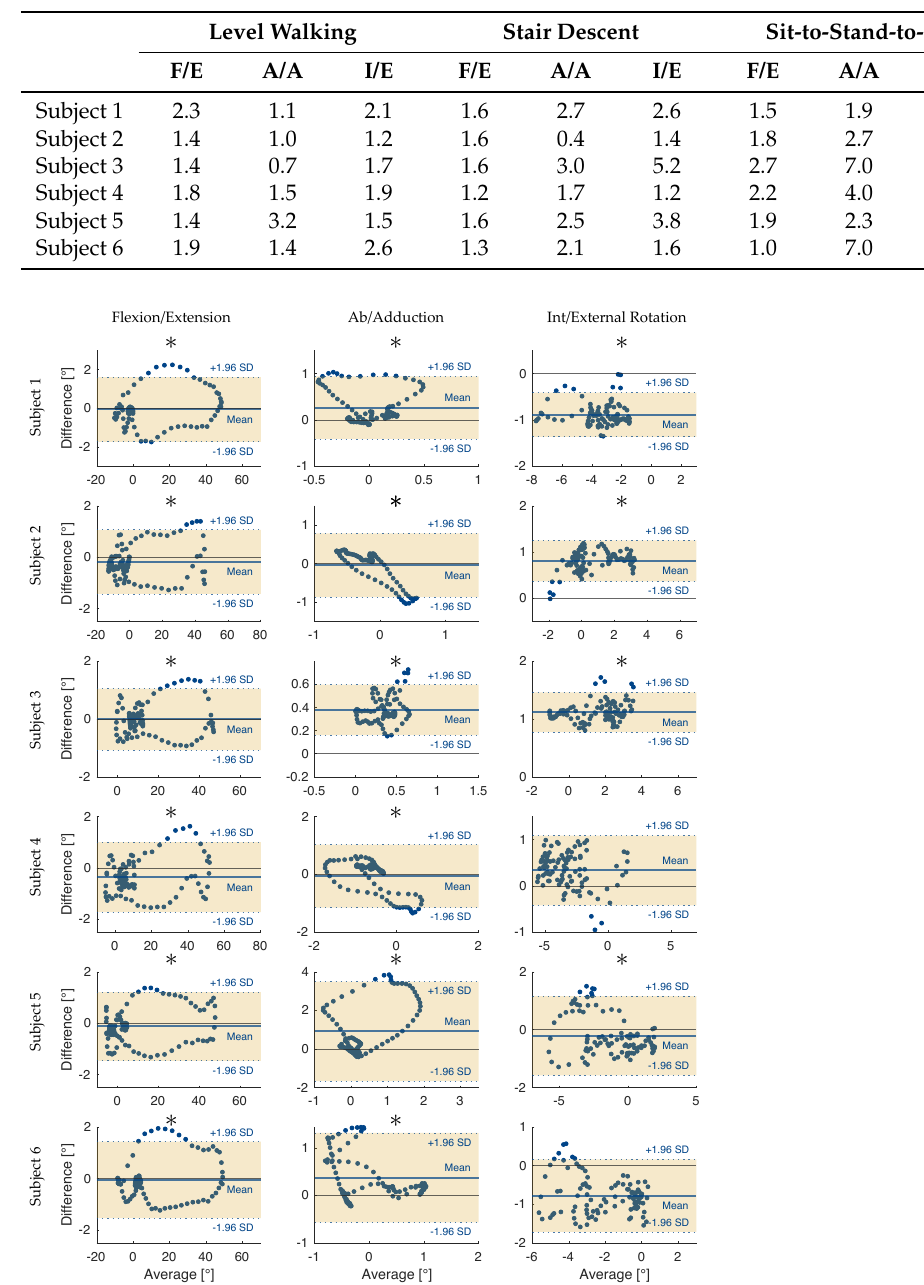
Figure A1. Bland-Altman plots for level walking. Differences between simulator- and IMU-based estimates were plotted against the average of the two measures. Shaded areas denote two-tailed 95% confidence intervals while dotted blue lines represent limits of agreement and solid blue lines show the mean difference. Each row corresponds to a different subject; each column to a different plane of rotation. Inclusion of an asterisk indicates the assumption of normality was not